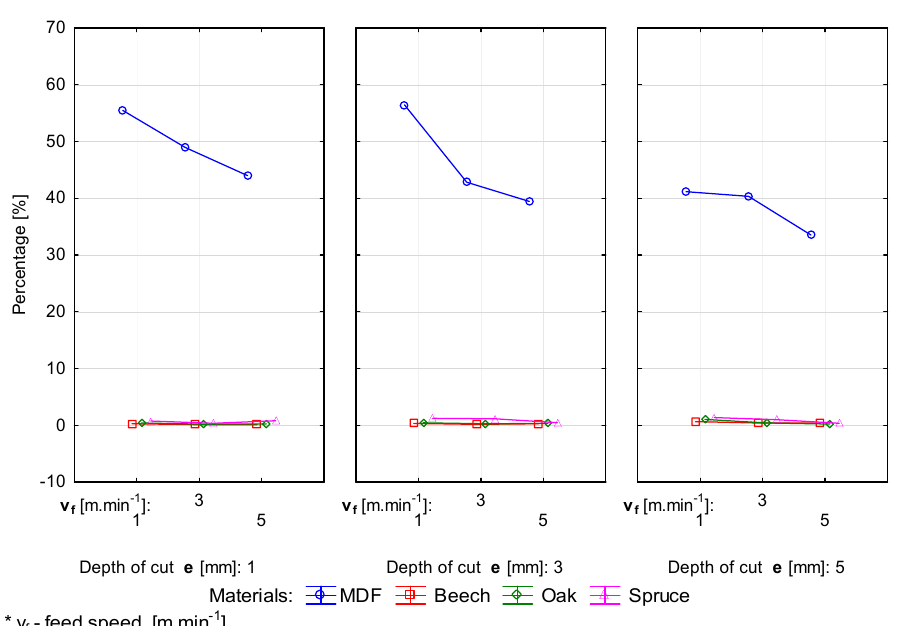
Figure 7. Grain size grade 63 μ m.